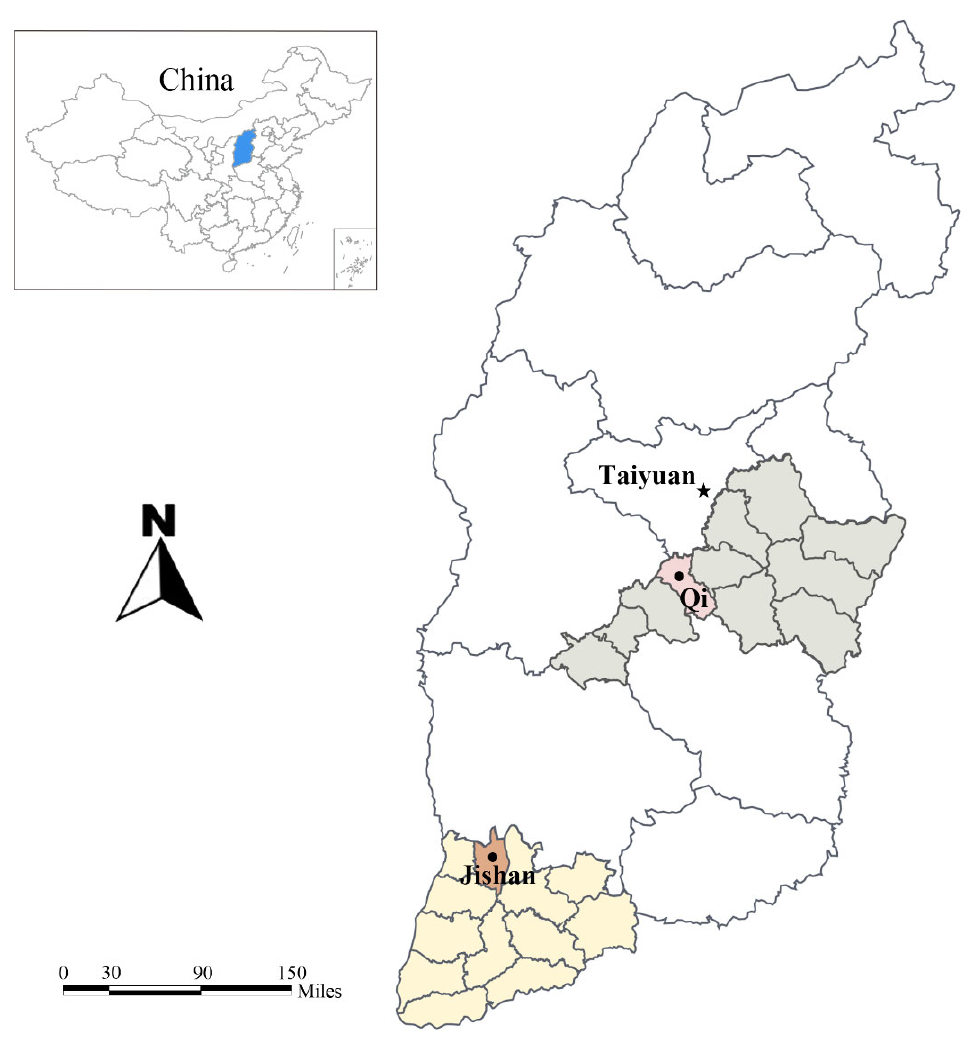
Figure 1. Sampling locations (Qi county and Jishan county) of beef cattle feces in Shanxi province, north China.